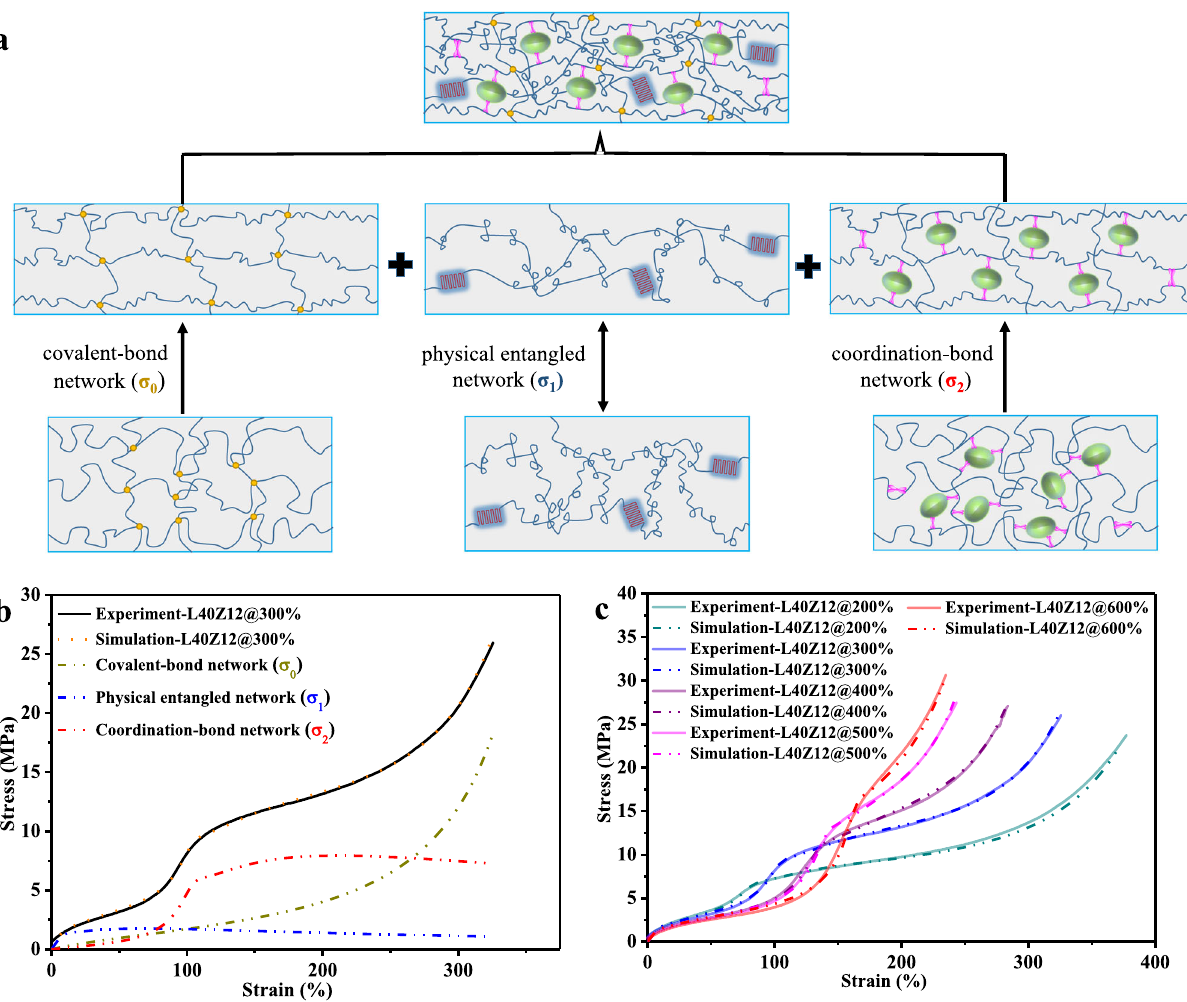
Fig. 5 Theoretical simulation for the arti fi cial muscle material. a Schematic illustration of the variation of the covalent-bond network ( σ 0 ), physical entangled network ( σ 1 ), and coordination-bond network ( σ 2 ) when the training strain increased. b The simulation of engineering stress – strain curve for L40Z12@300%, including covalent-bond network ( σ 0 ), elastic network ( σ 1 ), and coordination-bond network ( σ 2 ). c The simulation results of engineering stress – strain curves for the samples trained at different strains. Source Data for Fig. 5b – c are available as an associated article fi